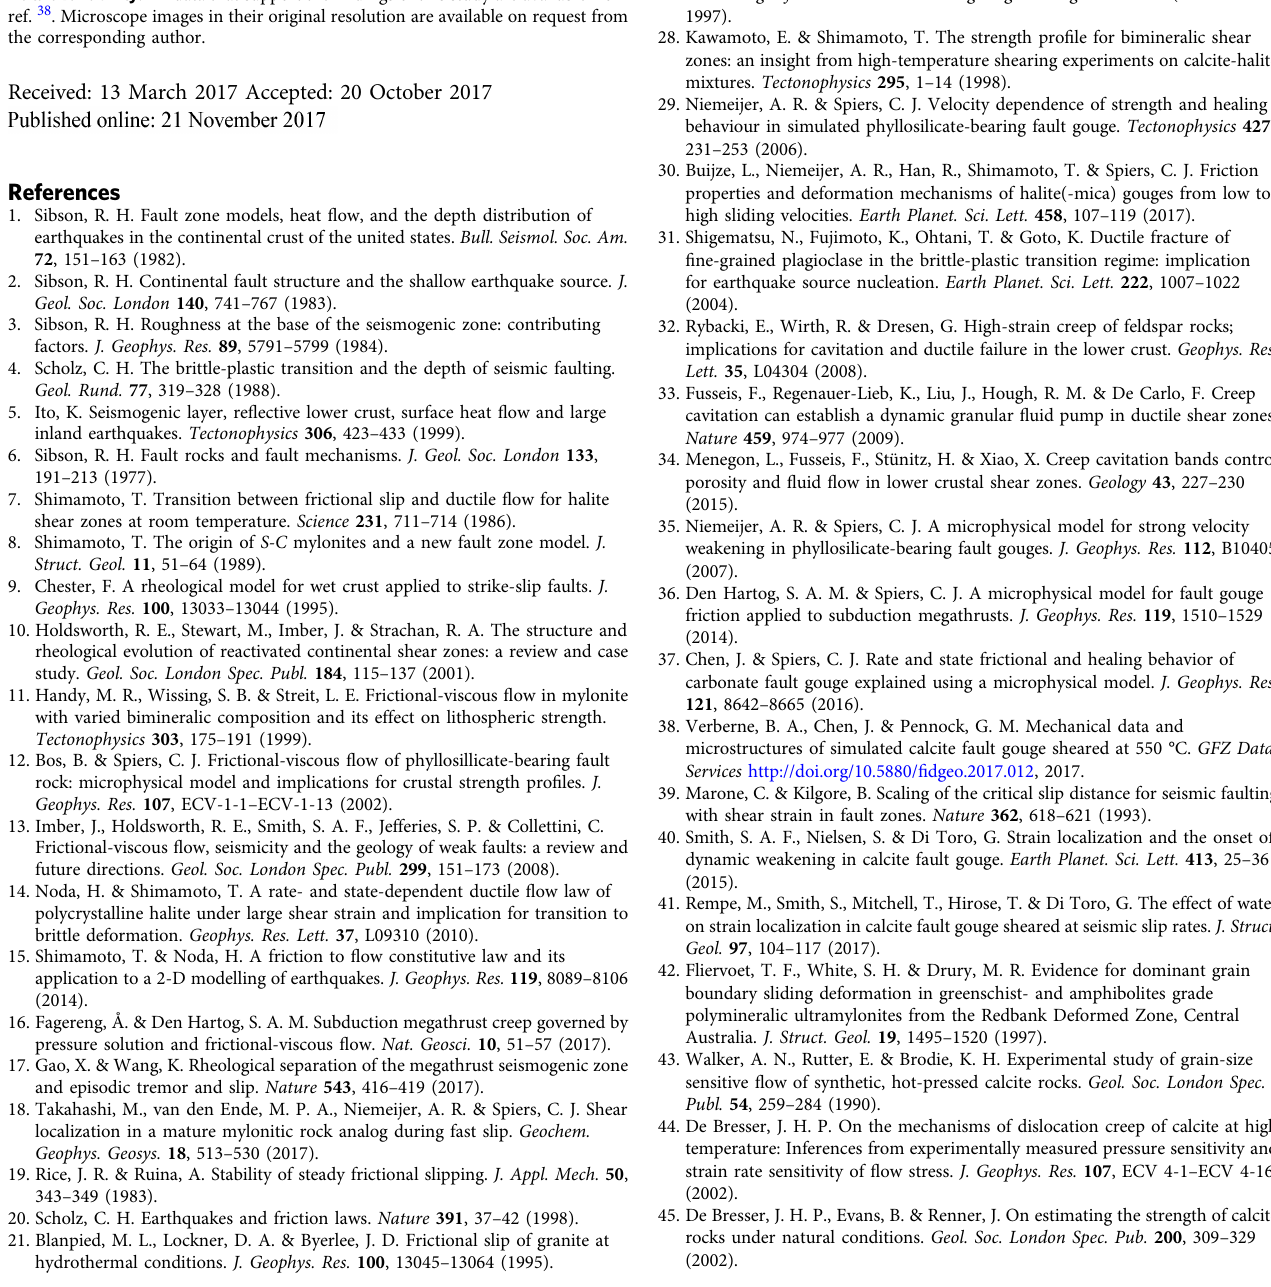
Using equations 1 and 2, plus kinetics parameters for surface-diffusion- controlled, static growth of calcite grains 49 , we simulated the grain size that may have developed in the fi rst 110 s of cooling of our samples, for initial grain sizes ranging from d 0 = 0.01 – 0.6 µ m in size (Supplementary Fig. 6). This shows that, regardless of the initial size d 0 , the bulk of grain growth will have been achieved within the fi rst ~20 – 25 s of cooling. Also, for grains with an initial size smaller than ~0.25 µ m, the fi nal size is more or less constant at d ≈ 0.4 µ m (cf. Fig. 3), whereas for grains with d 0 exceeding 0.25 µ m, the total growth in size ( d – d 0 ) will be limited to < 0.1 µ m. Allowing for differences in the detailed diffusion mechanisms 49 , the minimum grain size found in our samples thus roughly corresponds with the “ minimum ” grain size as predicted by diffusion-controlled grain